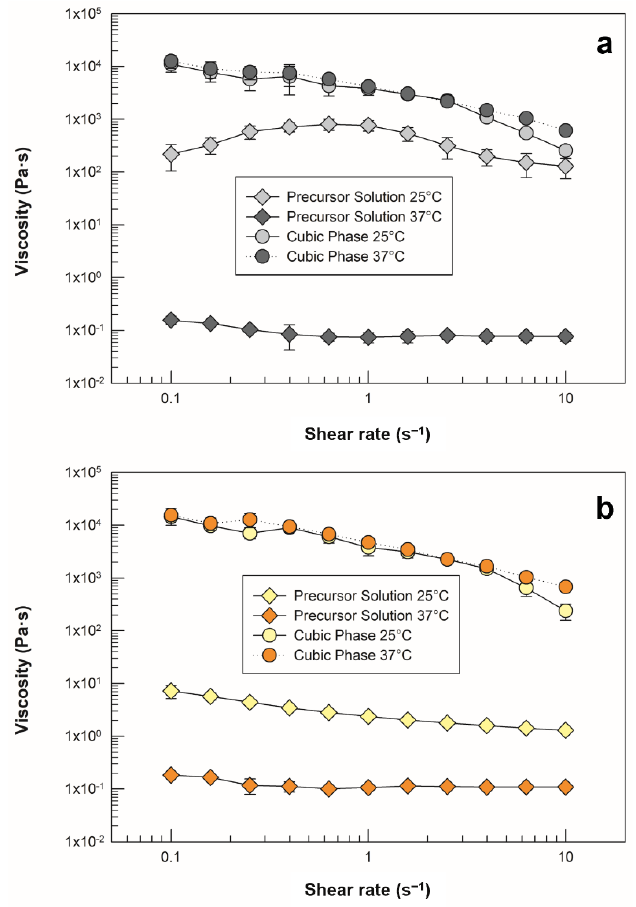
Figure 6. Viscosity profiles of ( a ) empty precursor solution and cubic phase, as well as ( b ) drug-loaded precursor solution and cubic phase. Analyses were carried out at 25 ± 0.5 ◦ C (light grey and light yellow symbols) and 37 ± 0.5 ◦ C (dark grey and orange symbols). The data are reported as mean values ± standard deviation; the error bars, if not shown, are smaller than the symbol size.